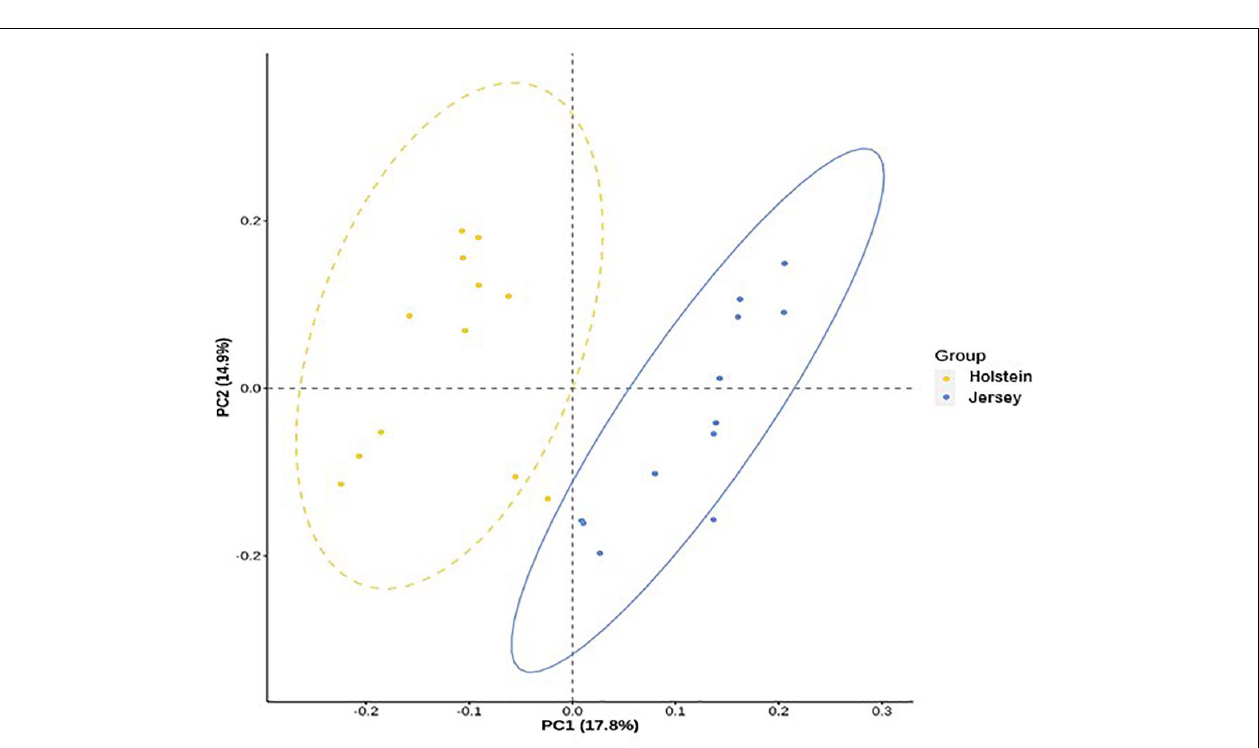
FIGURE 5 | Principal coordinates analysis plot based on Bray–Curtis dissimilarity with ellipse at 95% confidence showing the comparison of the overall rumen microbiota of the Holstein and the Jersey steers.